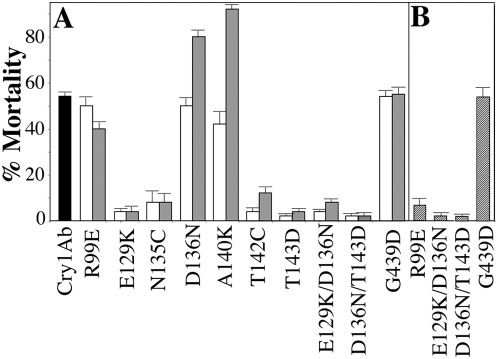

In vivo analysis of the Dominant Negative phenotype of Cry1Ab mutants.Panel A, Toxicity assays against M sexta larvae with Cry1Ab at 2 ng/cm2 of diet (black bar) or with a mixture of the same concentration of Cry1Ab wild type with the mutant proteins at two different ratios, 0.25∶1 mutant:wild type (white bars) or 1∶1 (grey bars). Some mutants of helix α-4 show a clear DN phenotype. Panel B, Toxicity assays against M sexta larvae as panel A but at 10∶1 mutant:Cry1Ab ratio (dashed bars). R99E reduce toxicity of wild type under this condition in contrast mutant G439D did not affect toxicity of the wild type toxin.